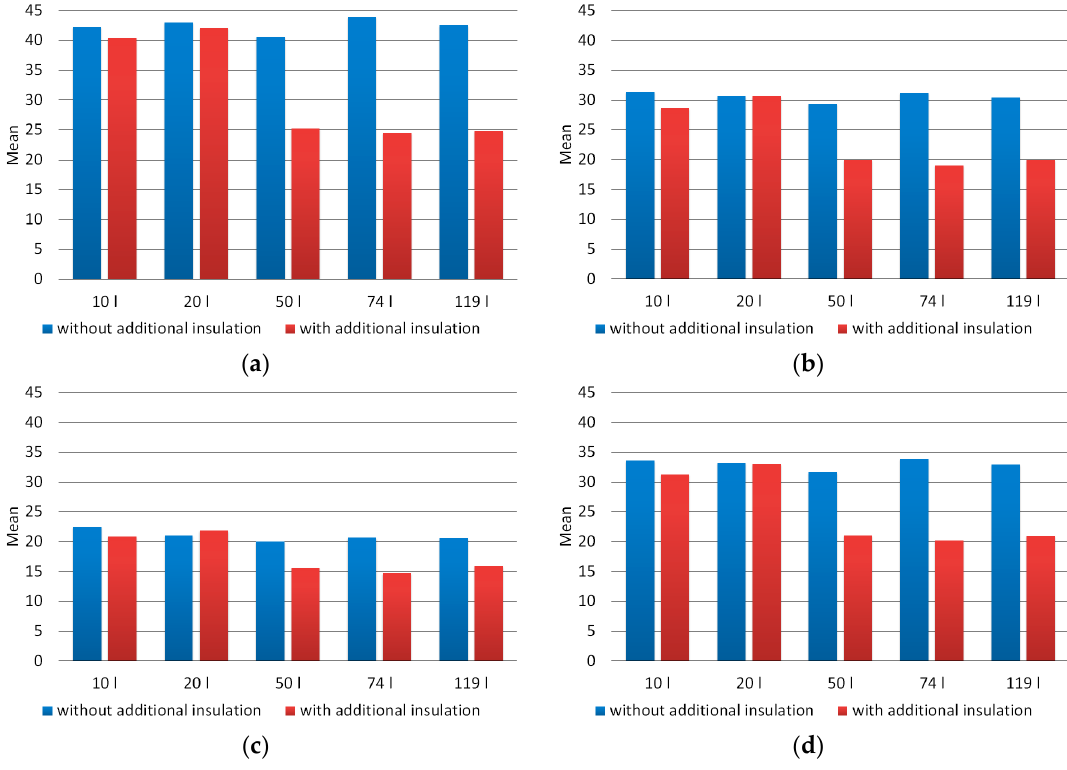
( d ) Figure 6. Median brightness of the pixel averaged for images of composted material ( a )—component R, ( b )—component G, ( c )—component B, ( d )—grayscale.